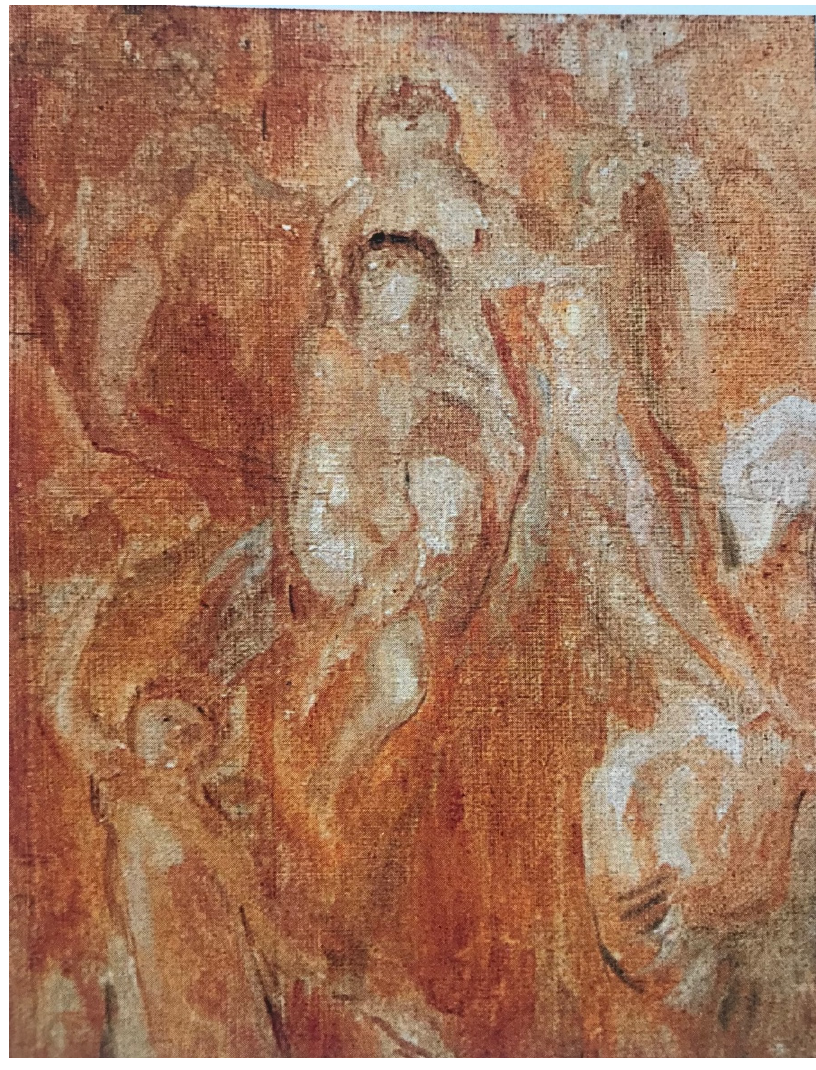
Figure 1. Vasily Chekrygin, Souls , 1914–1915, oil on canvas, private collection.